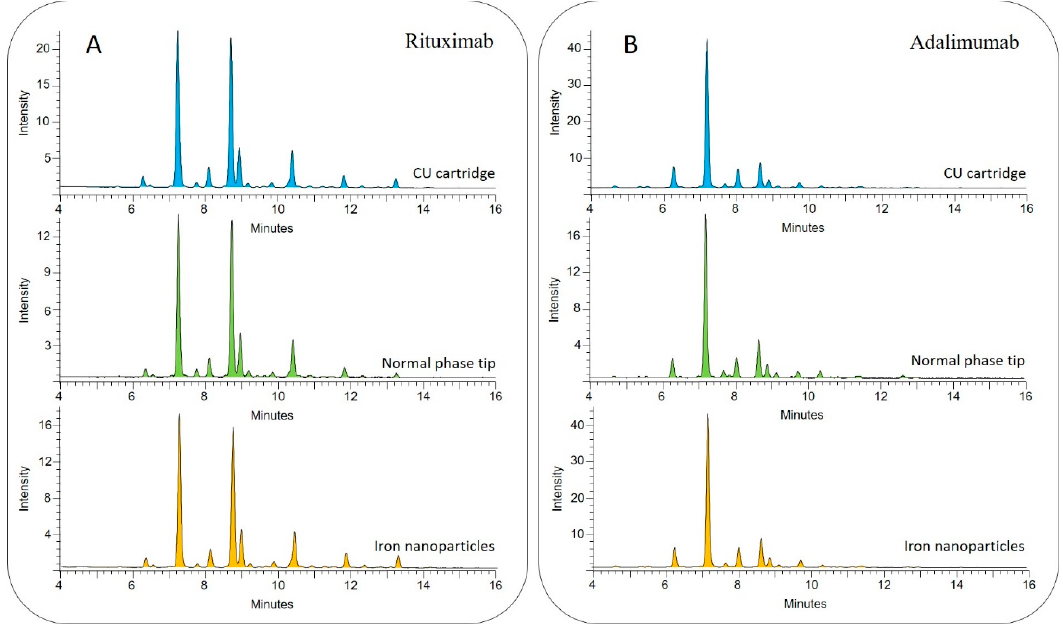
Figure 3. HILIC-UPLC profile of ( A ) rituximab and ( B ) adalimumab glycans purified by traditional methods (blue and green) and in-house synthetized magnetic iron nanoparticles (orange).